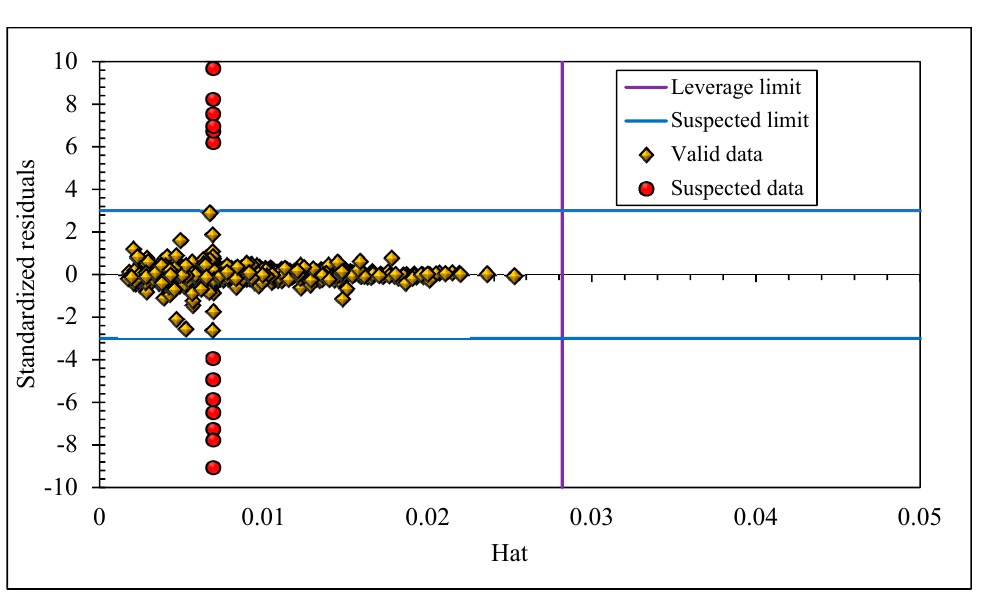
Figure 6. Williams plot of the MLP-LMA model.